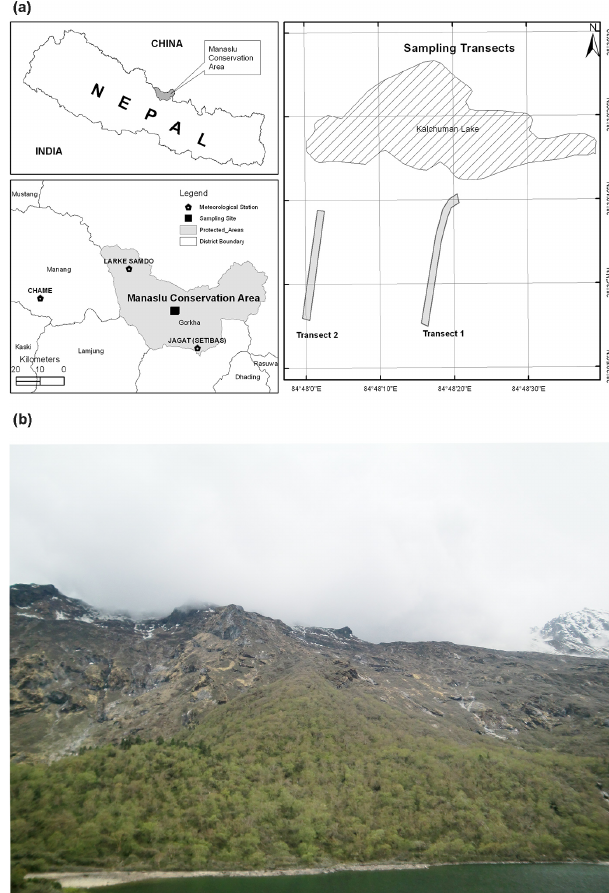
Figure 2. Location map of the study area showing the position of the study plots and local meteorological stations (a) , and a photo of the study site showing treeline, species limit and some portion of Kalchuman Lake (b)